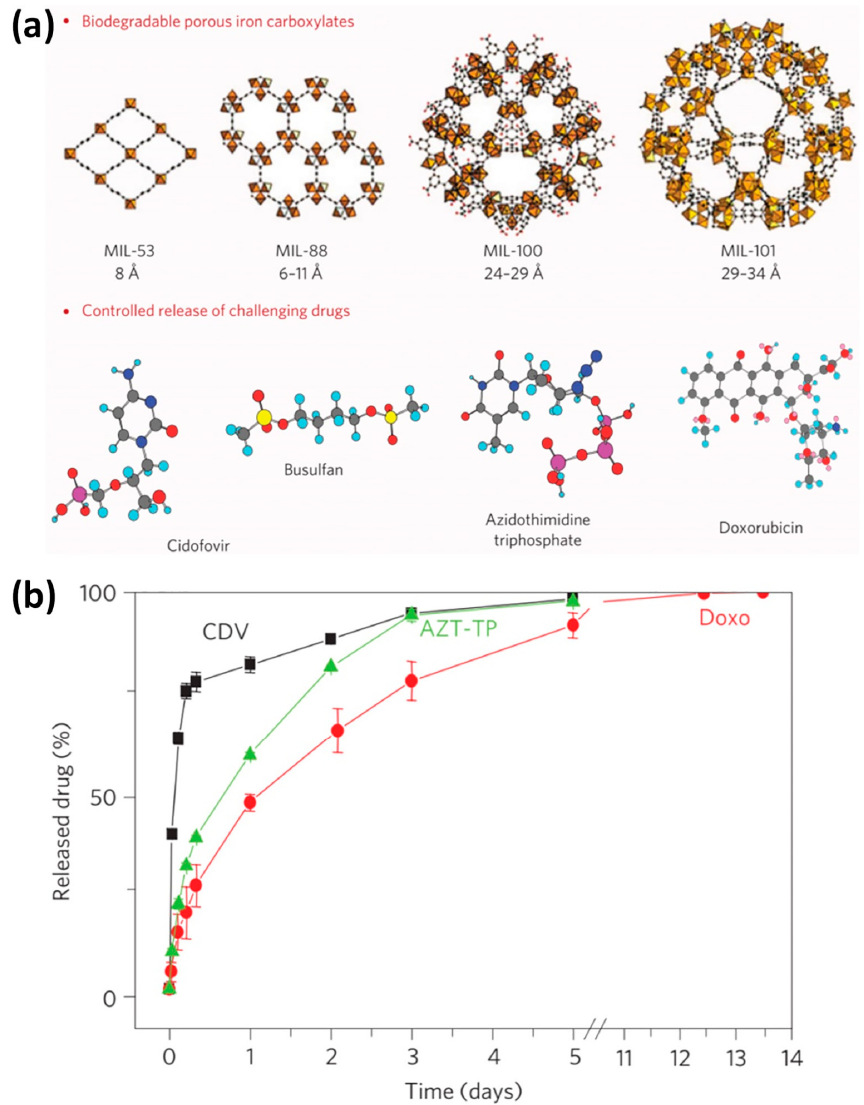
Figure 5. ( a ) Schematic diagram showing four ferric carboxylate MOFs for drug delivery. ( b ) The released drug curves of cidofovir (CDV), doxorubicin (DOX) and azidothymidine triphosphate (AZT–TP) under simulated physiological conditions from Fe–MIL–100 nanoparticles. Reproduced from Ref. [5] with permission of Nature Publishing Group, copyright 2010.